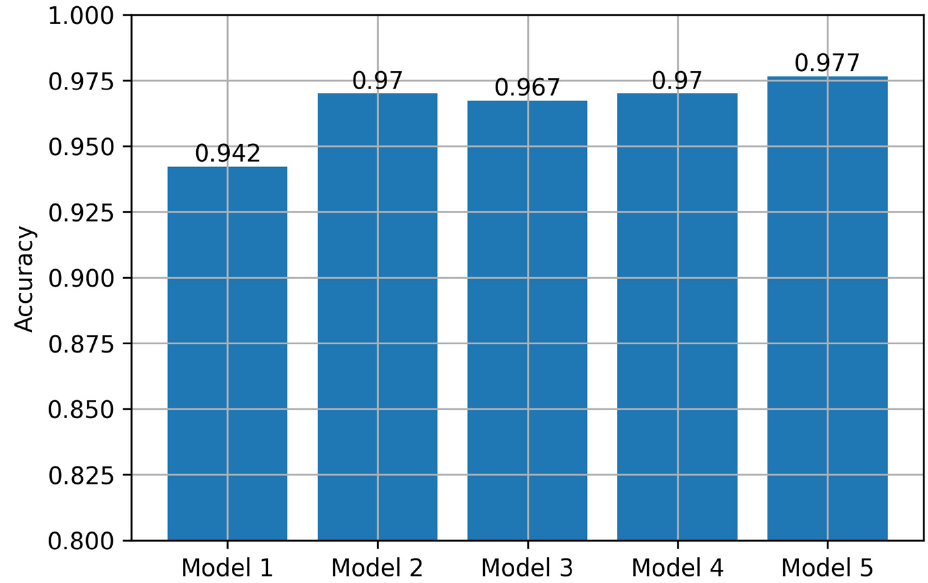
Figure 12. Accuracy of VGG16 models with data augmentation.